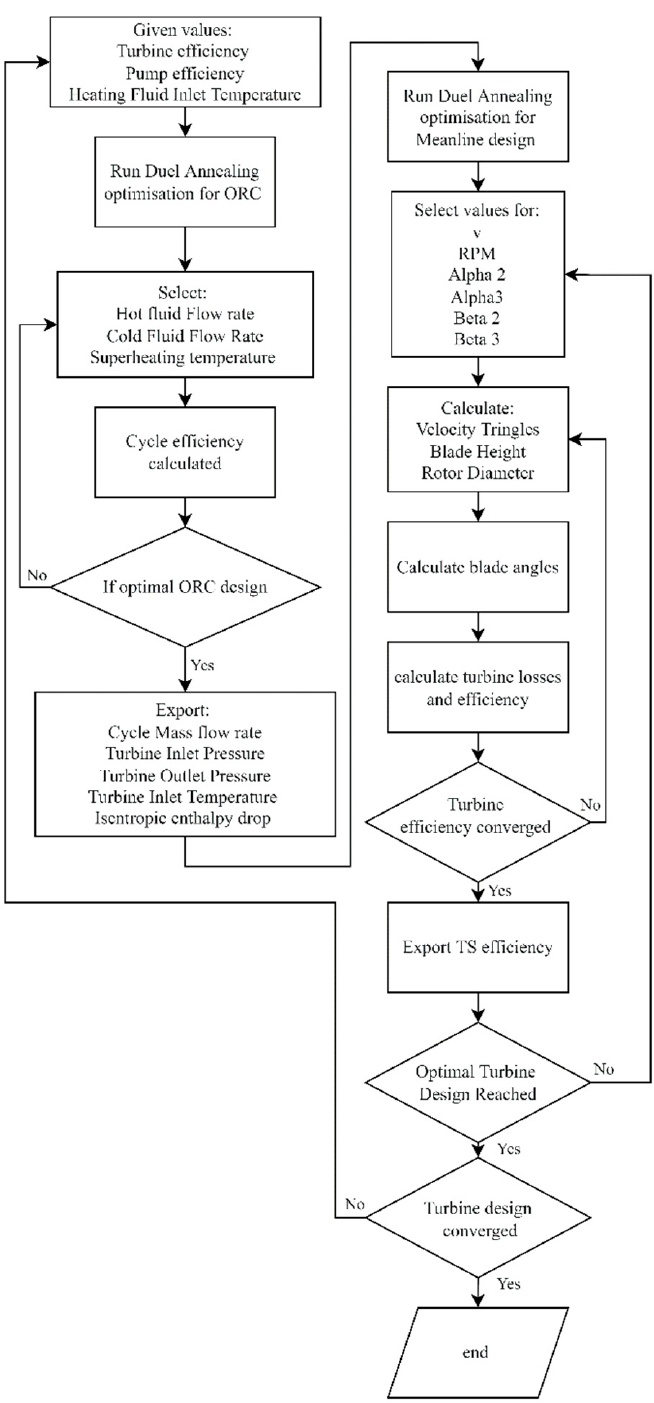
Figure 2. Flow chart of ORC, turbine design, and optimization procedure.